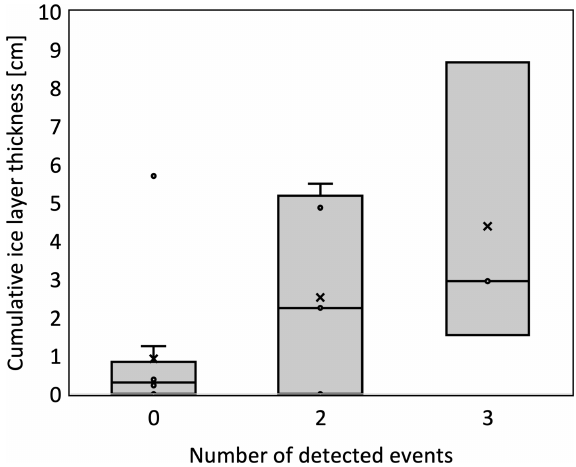
Figure 12. Boxplots for ASCAT grid point average cumulative snow layer thickness for hardness class 6 (for definition see Table 1) from snowpits at Varanger (66 locations in six ASCAT GPIs; mid- dle to end of March 2017–2020) and at Saariselkä (two locations in one ASCAT GPI; 18 March 2021). Separation for number of de- tected potential rain-on-snow events between November and Febru- ary and sum for class 6. Snow depth range: 20–234cm on Varanger and 42–66cm at